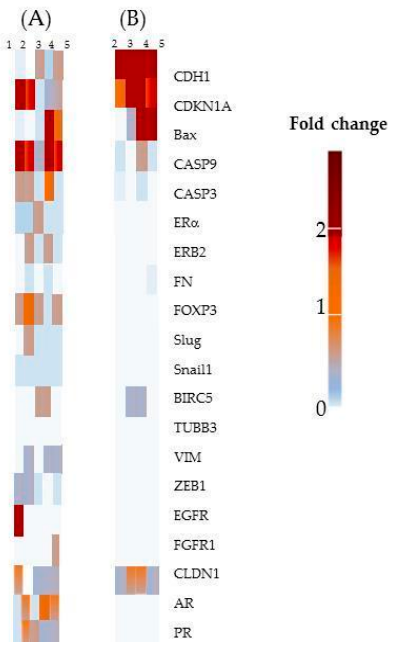
Figure 11. Fold change in gene mRNA expression of the 20-gene signature in MCF-7 cells. ( A ) Fold change in comparison to control. ( B ) Fold of change in comparison to DOCE. 1, DOCE (120 nM)- treated cells; 2, CAT (50 µ M)-treated cells; 3, ProB2 (50 µ M)-treated cells; 4, CAT (50 µ M) plus DOCE (120 nM)-treated cells; 5, ProB2 (50 µ M) plus DOCE (120 nM)-treated cells. Abbreviations: AR, androgenic receptor; BAX, BCL-2-associated X protein; BIRC5, baculoviral inhibitor of apoptosis repeat-containing 5; CDH1, cadherin type 1, E-cadherin; CDKN1A, cyclin-dependent kinase inhibitor 1A; CASP9, caspase-9; CASP3, caspase-3; CAT, catechin; CLDN1, claudin 1; DOCE, docetaxel; EGFR, epidermal growth factor receptor; FGFR1, fibroblast growth factor receptor 1; FN; fibronectin; FOXP3, forkhead box protein P3; ProB2, procyanidin B2; SLUG, snail family zinc finger 2; ZEB1, zinc finger E-box-binding homeobox 1; VIM,